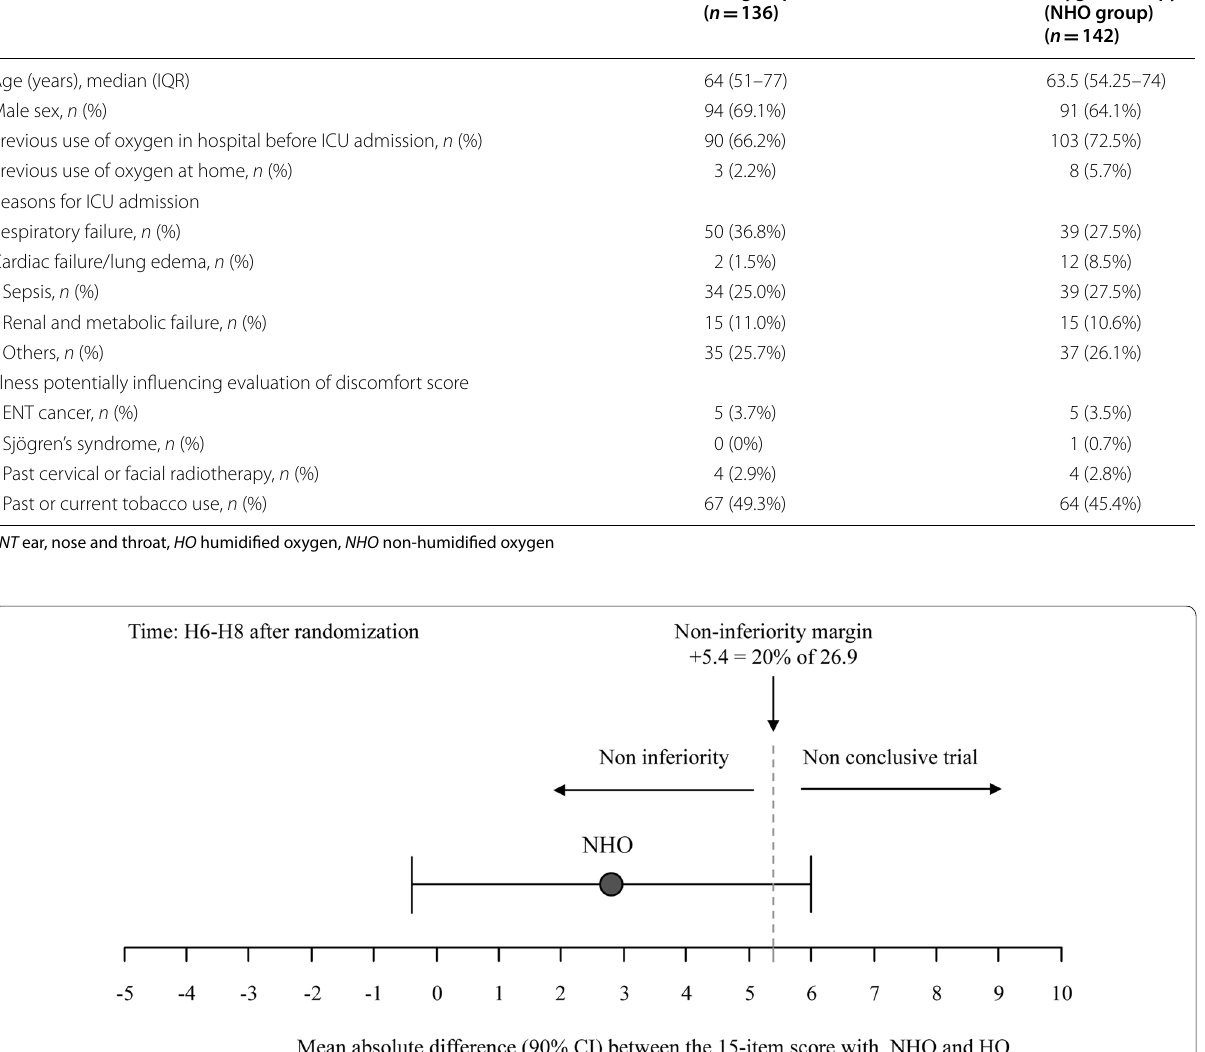
Table 1 Patients’ characteristics, reasons for intensive care unit (ICU) admission and past medical history Characteristics